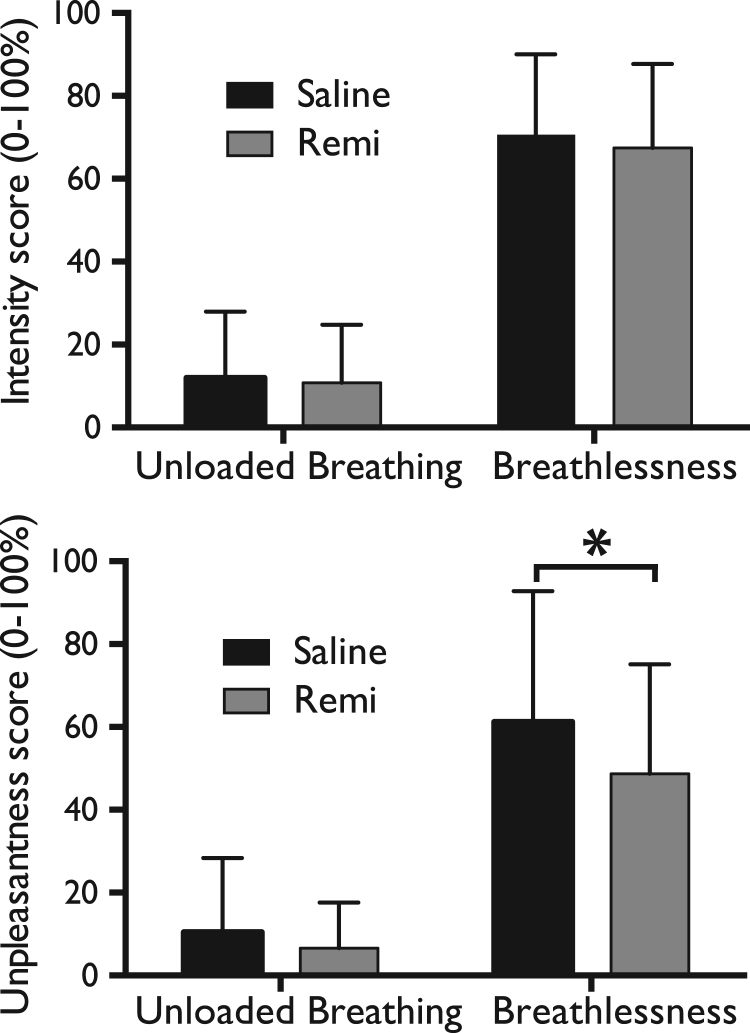
Breathlessness intensity and unpleasantness scores (on a visual-analogue scale of 0–100%) during unloaded breathing and breathlessness during both saline and remifentanil (Remi) administration. Bars represent group mean, and error bars standard deviation. *Significantly different between the groups (p<.05).